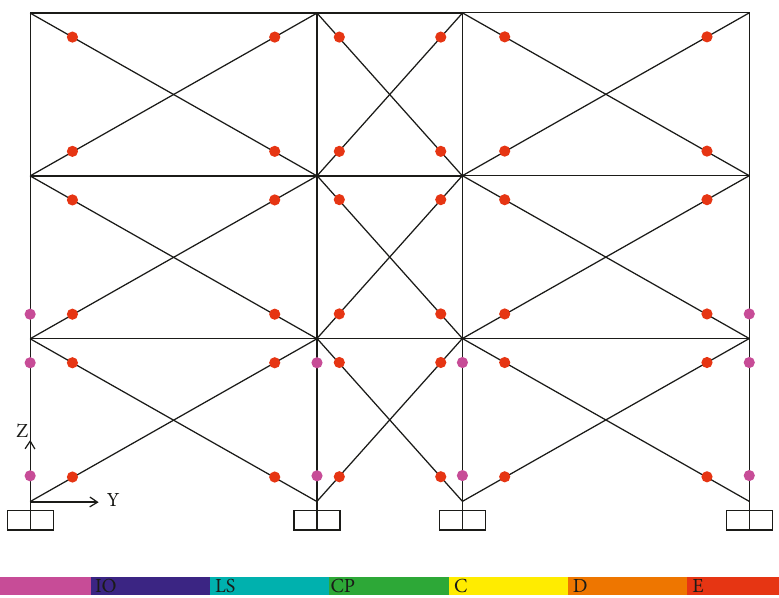
Figure 11: Sequence of hinges formation in the Y